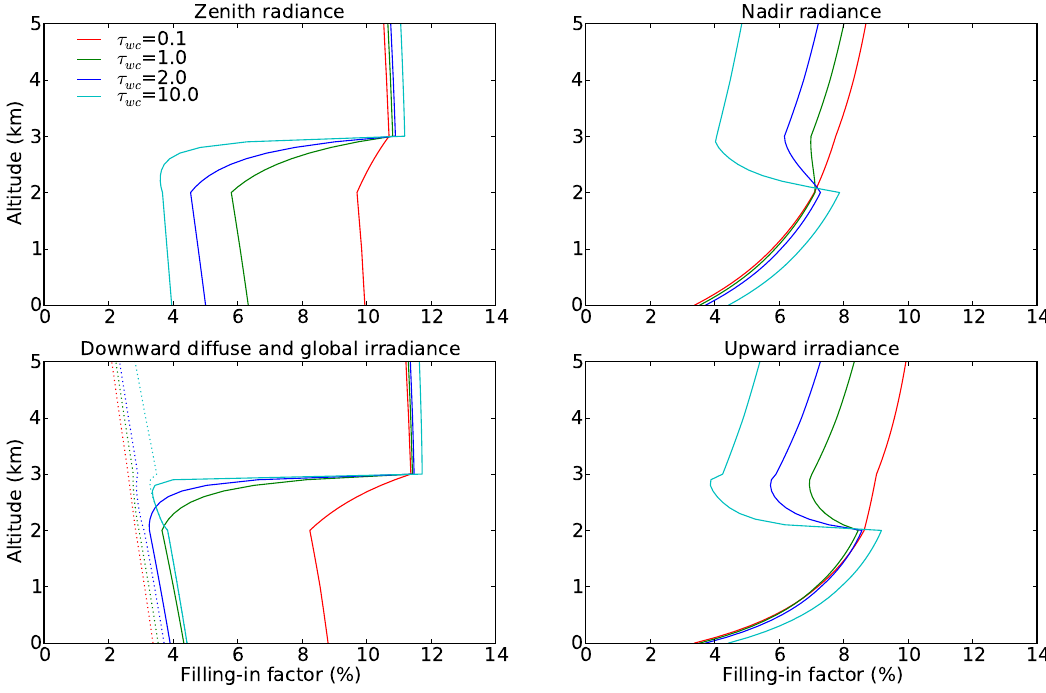
Fig. 6. Profiles of the filling-in factor as calculated from radiances (top row) and irradiances (bottom row). Solid lines represents filling-in factors calculated from radiances (upper row) and diffuse upward and downward irradiances (lower row). Dashed lines are filling-in factors calculated from the global (direct plus diffuse downward) irradiance. As in Spurr et al. (2008) the cloud layer was located between 2 and 3km and the surface at 0.0km. Altitude resolution